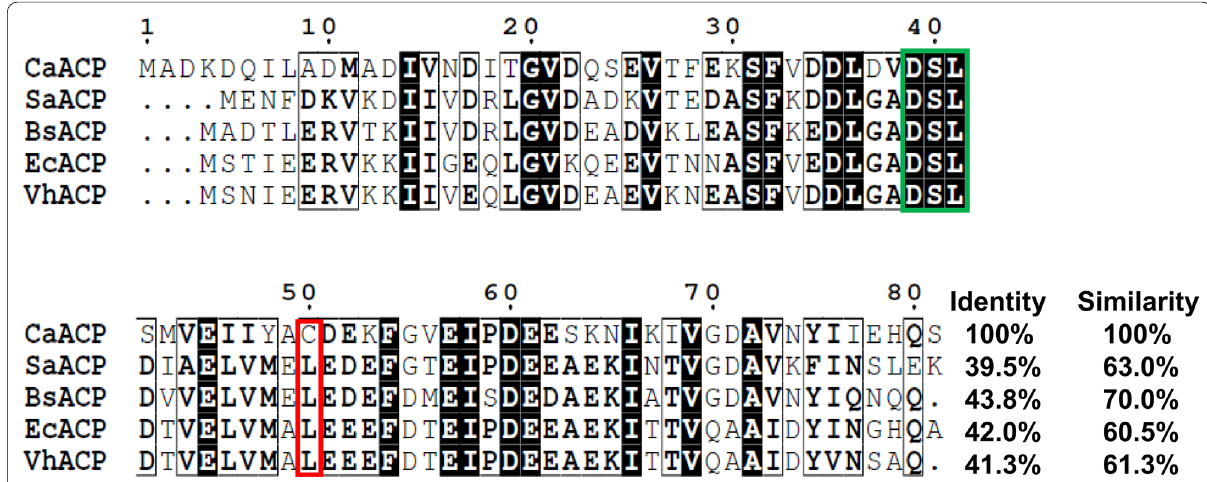
Fig. 1 Comparison of bacterial ACP sequences. The black boxes show the 100% conserved residues. Residues having similar properties are shown in white boxes. Based on the CaACP, the identity and similarity of each ACP is marked. The conserved DSL motif is marked in a green box. The unique Cys50 residue in CaACP is marked in red